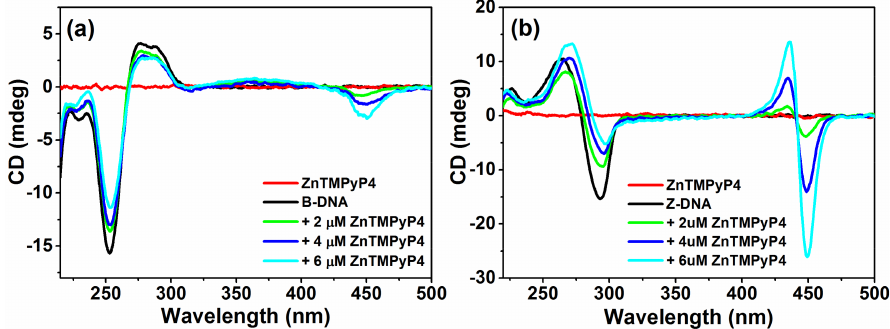
Figure 4. CD spectra of ( a ) B-DNA (50 µ M) and ( b ) Z-DNA (50 µ M) in the presence of different